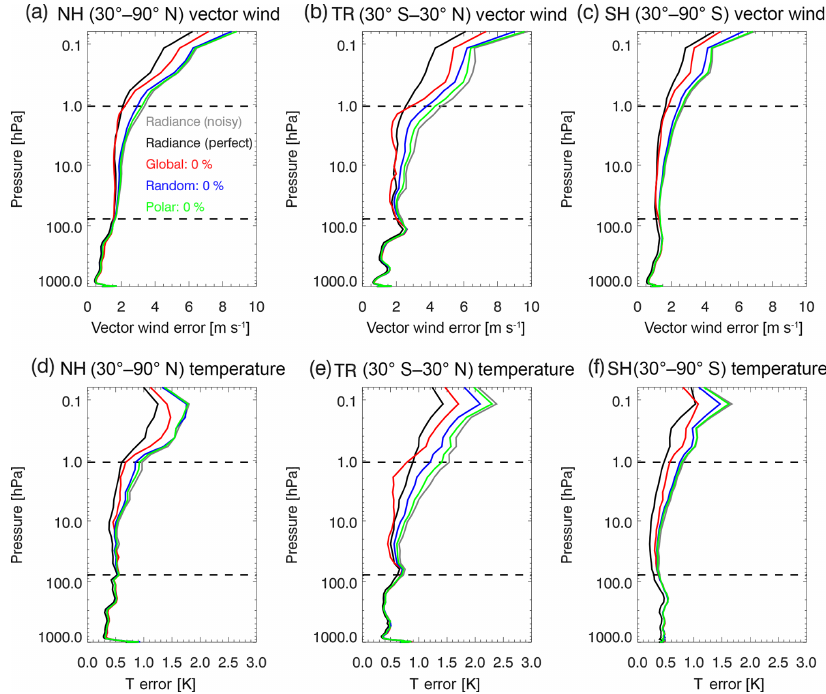
Figure 21. The rms vector wind errors (ms − 1 ) averaged from 25 November to 1 December 2014 for (a) NH, (b) TR, and (c) SH and rms temperature errors (K) for the (d) NH, (e) TR, and (f) SH. Colored lines are for ozone assimilation experiments with noisy radiance and perfect ozone data using the sampling pattern of global (red), random (blue), and polar (green). Black (grey) lines are for radiance-only assimilation for perfect (noisy) data (same as in Fig. 20). Horizontal dashed lines indicate vertical range of assimilated stratospheric ozone observations. See Table 1, Sect. 5.1 and